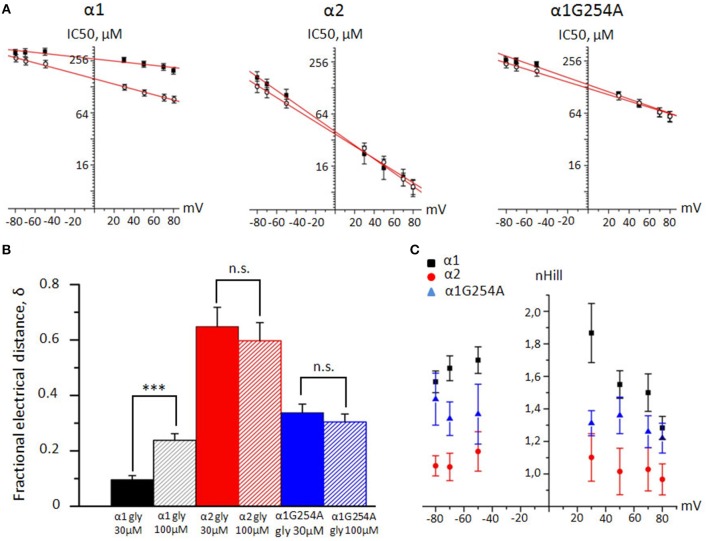
Woodhull and cooperativity analysis of NFA interaction with α1, α2, and α1 G254A GlyRs. (A) Linear fit of the cumulative IC50 values plotted against membrane potential for α1, α2 and G254A-α1 GlyRs. Currents were evoked by 30 μM of glycine (filled squares) or by 100 μM of glycine (empty circles). (B) Mean fractional depth of NFA binding in the pore (δ) for α1 (black column), α2 (red) and G254A-α1 (blue) GlyRs. Currents were evoked by 30 (filled columns) and 100 μM (shaded) of glycine. Data from 6–10 cells. ***p < 0.001, unpaired t-test; n.s. – nonsignificant. (C) Cumulative nH values of NFA interaction with α1 (black squares, n = 6), α2 (red circles, n = 6) and G254A-α1 (blue triangles, n = 5) GlyRs plotted against membrane potentials. Currents were evoked by 30 μM of glycine. Data represented as mean ± SEM.